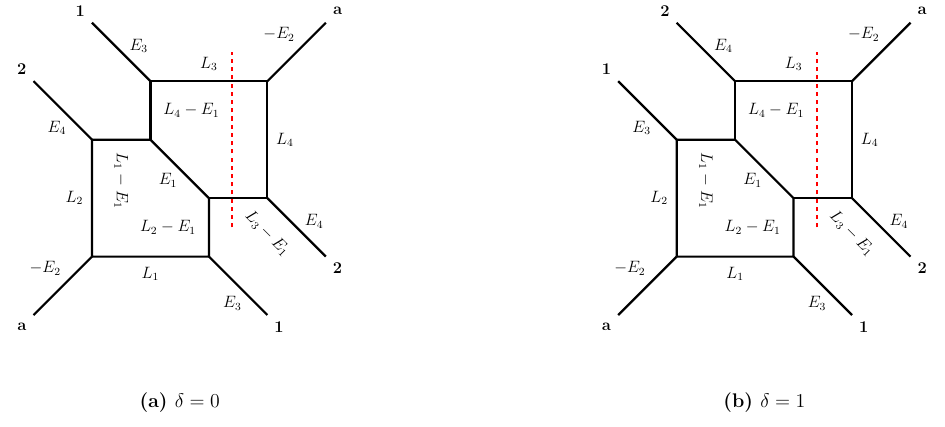
Figure 16 . Geometry (cid:12)gure 15 after a (cid:13)op transition of the curve (cid:0) E 1 for (cid:14) = 0 (diagram (a)) and (cid:14) = 1 (diagram (b)).